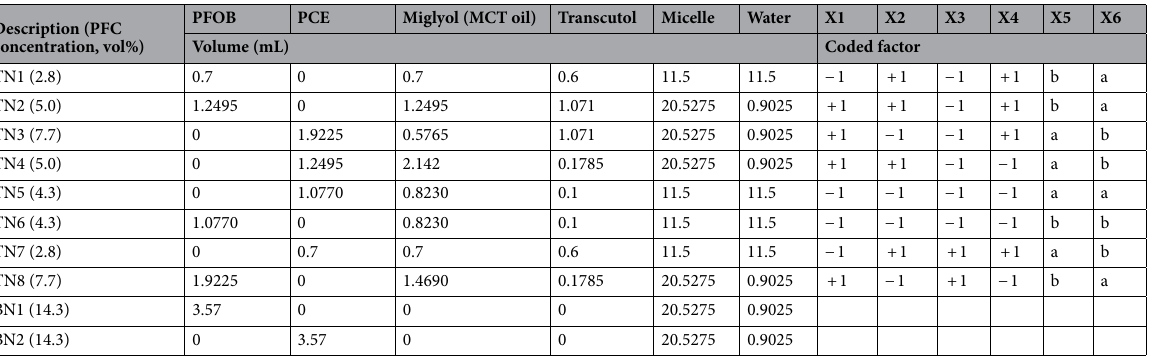
Table 2. List of formulations and the design matrix in 2-level, 6-factor d-optimal screening design of experiments. The micelle solution was comprised of 2% w/v Pluronic P-105 and 3% w/v Pluronic P-123. X1,